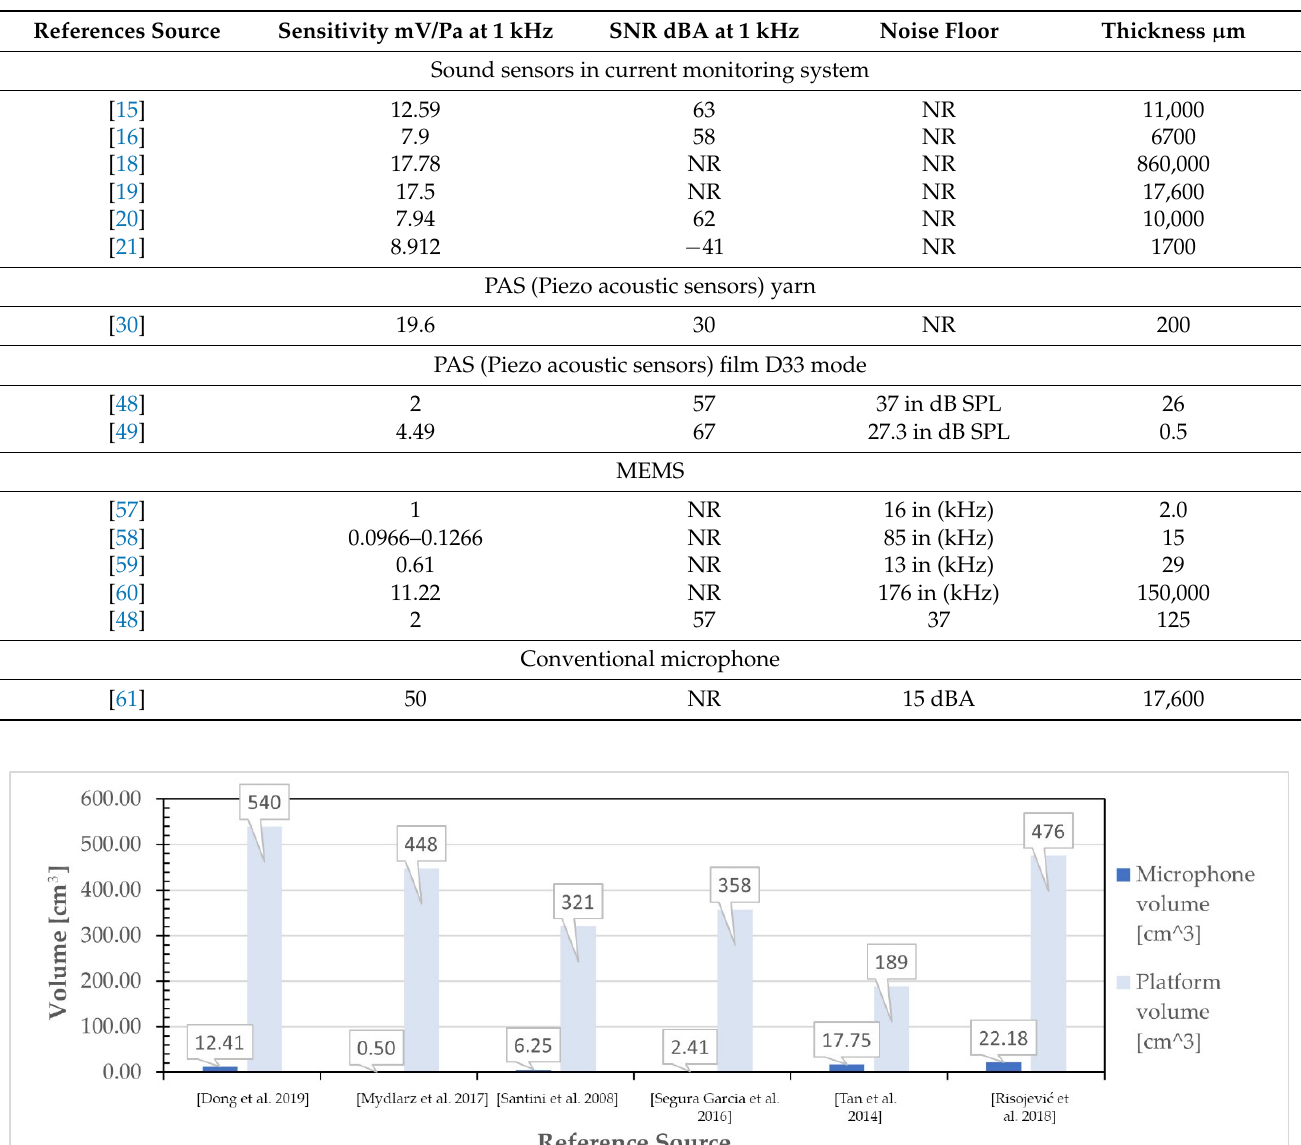
Table 4. Comparison of parameters between Pas D31, Pas D33, Acoustics MEMs and microphones.